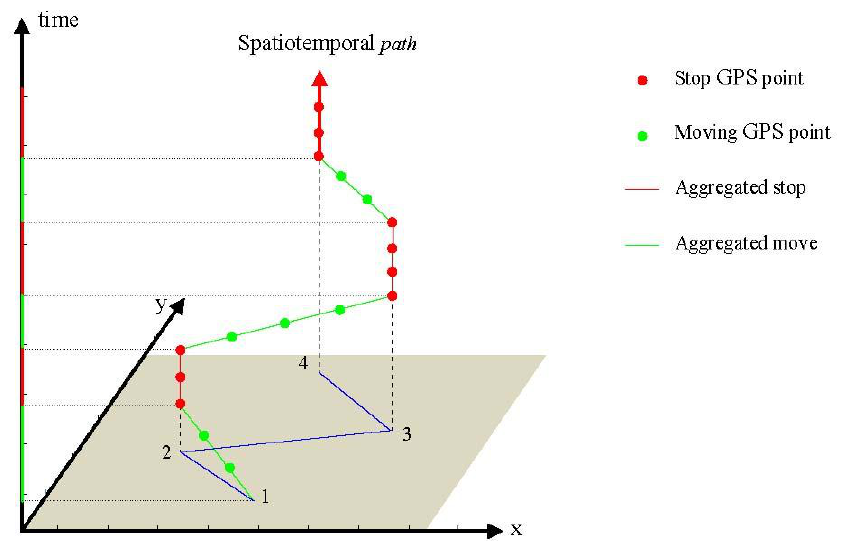
Figure 1. Data model representation of a spatio-temporal path of